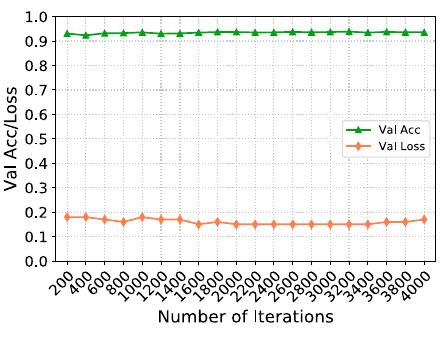
Figure 10. Val Acc/Loss graph.